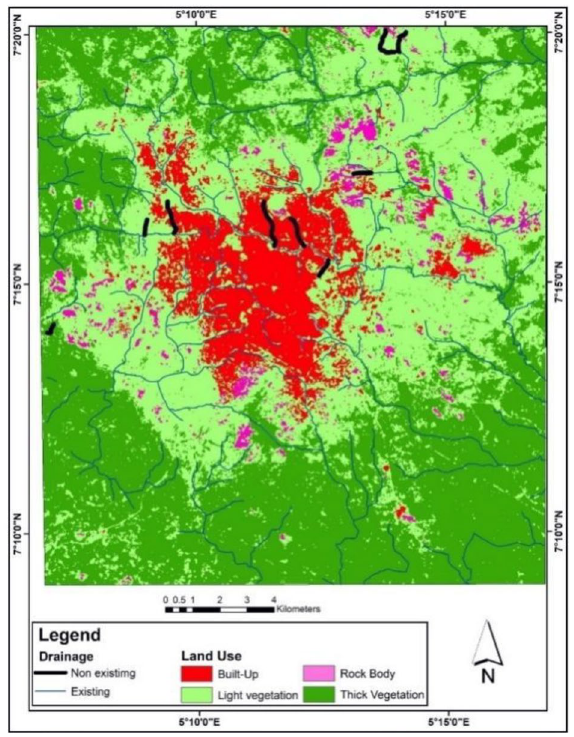
Fig. 3 Symmetric difference of drainages in 1986 and 2002